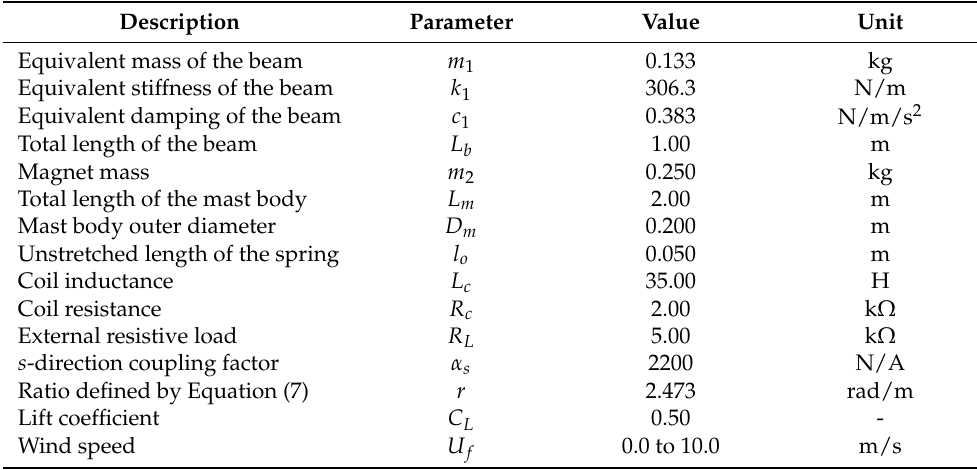
Table 1. Nominal parameters of the turbine used in this